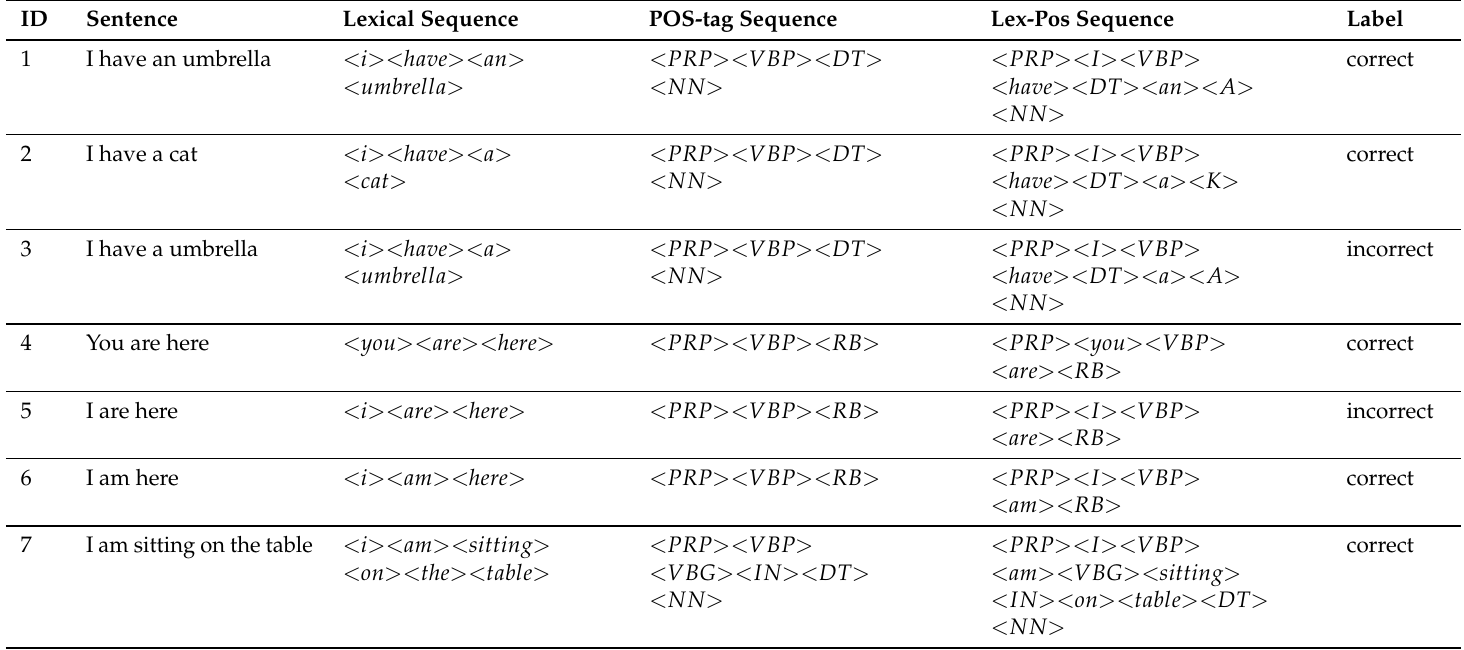
Table 1. Examples of Lex-Pos